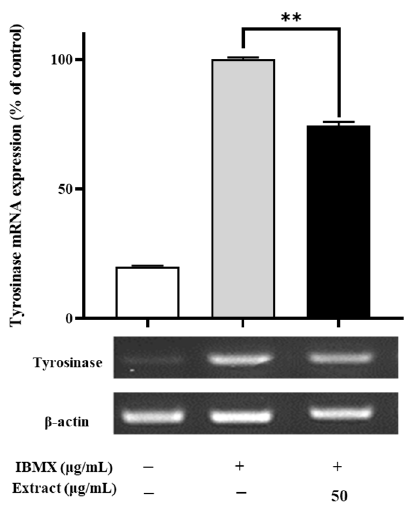
Figure 2. Anti-melanogenesis effect of enriched PLS extracts on mRNA expression. Representative images of PCR products are displayed. The β -actin was used as an internal control for equal loading. Data represent the mean ± SD of three independent experiments. ** p -value < 0.01 compared with IBMX induced group.